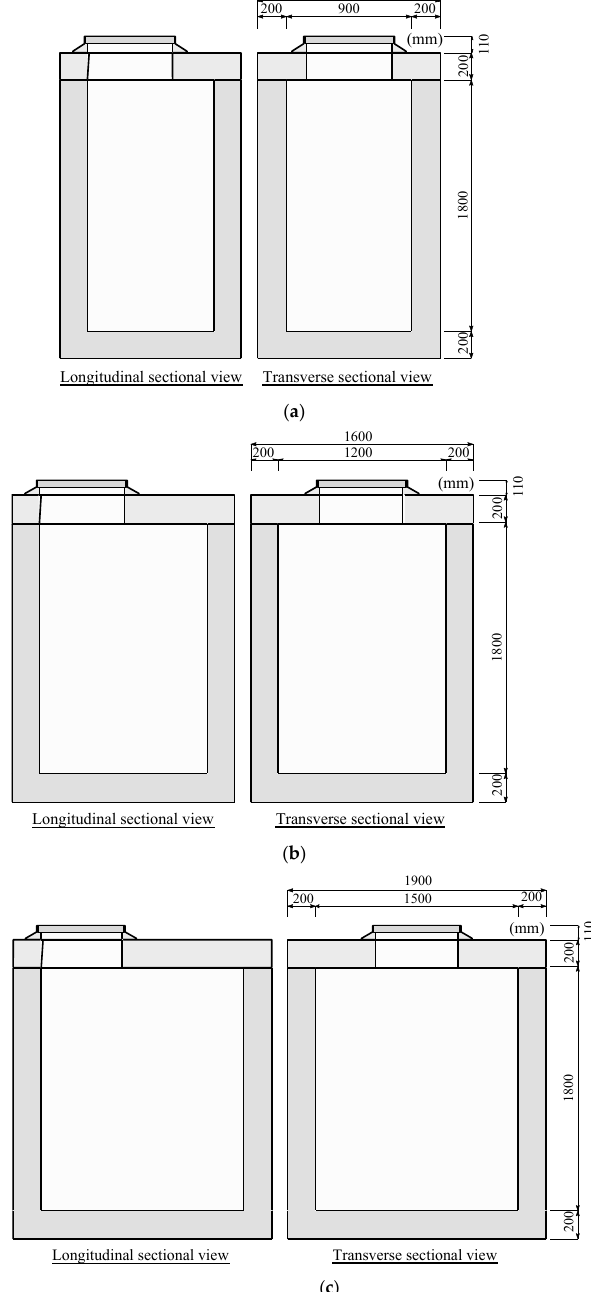
Figure 5. Specific dimensions of manholes Nos. 1, 2, and 3 in analysis. ( a ) No. 1 manhole ( b ) No. 2 manhole ( c ) No. 3 manhole Table 2. Assumed conditions for manhole.